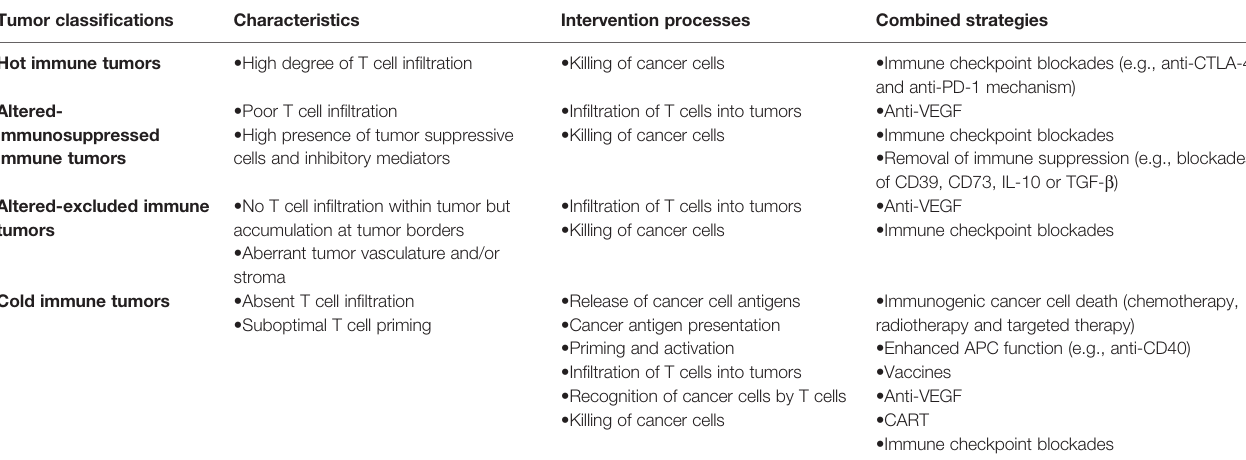
TABLE 1 | Intervention strategies based on the cancer-immunity cycle for different immune types of tumor. Tumor classi fi cations